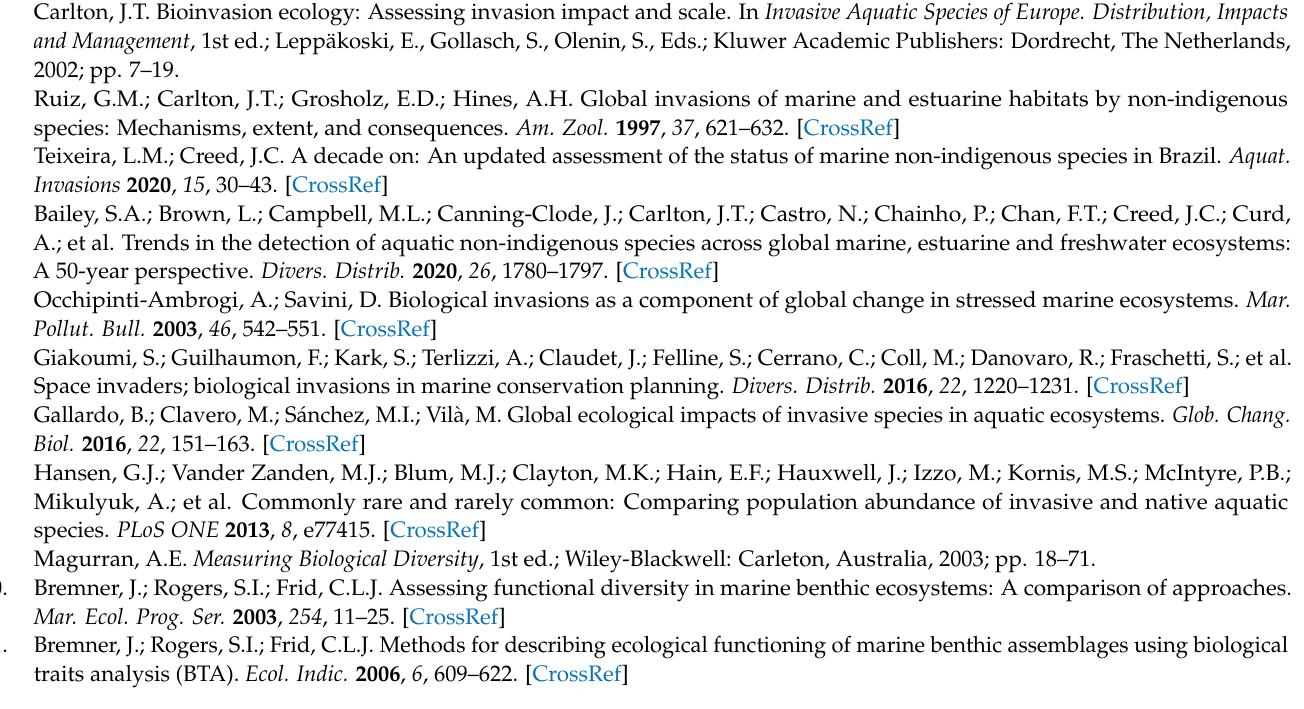
Supplementary Materials: The following are available online at https://www.mdpi.com/article/ study. Table S2: Major space-occupying taxa/functional groups, their percentage cover (%) in invaded and not-invaded communities on marine rocky shores along the coast of the state of Rio de Janeiro, Brazil. Table S3: Values of the taxonomic diversity index and functional diversity index. Table S4: Scores used for each trait modality in this